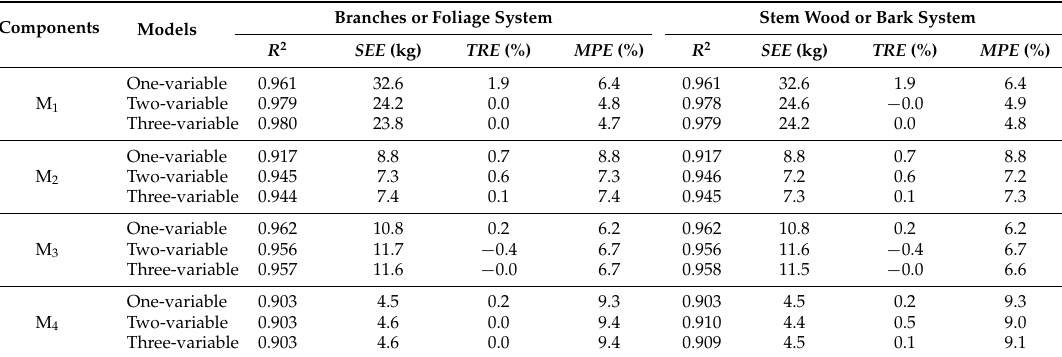
Table 5. Goodness-of-fit statistics for different systems of additive biomass equations. Components